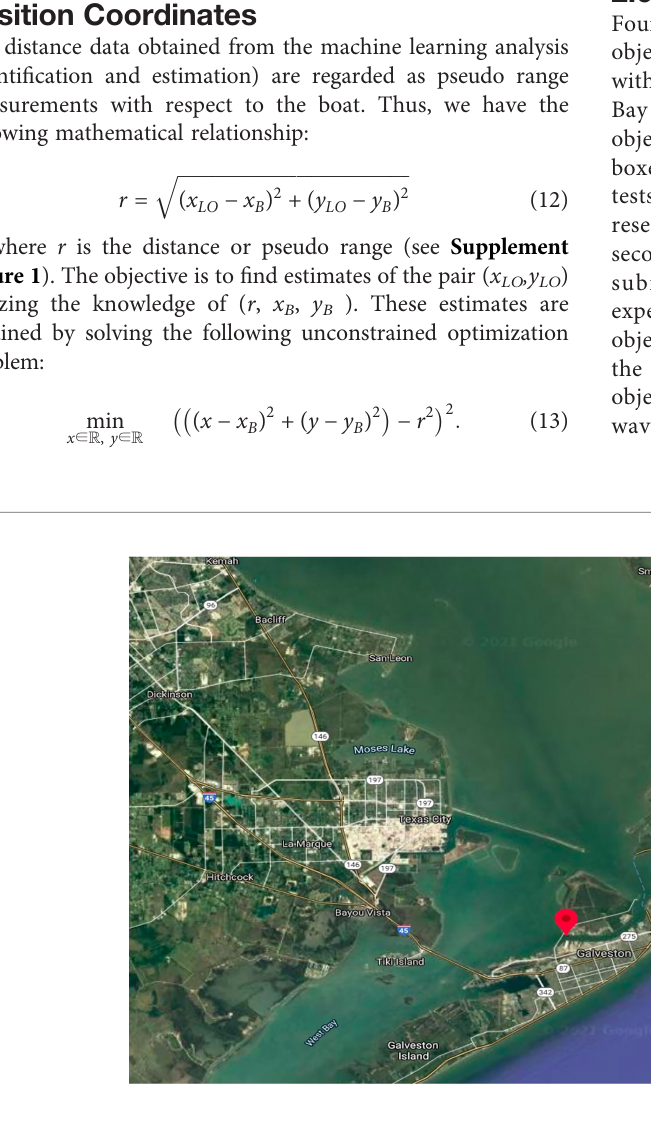
FIGURE 4 | Location of the fi eld test for data collection. At the docking area, the data-collection platform was fi tted on the boat. The boat was steered 5 miles inside the bay and the objects were